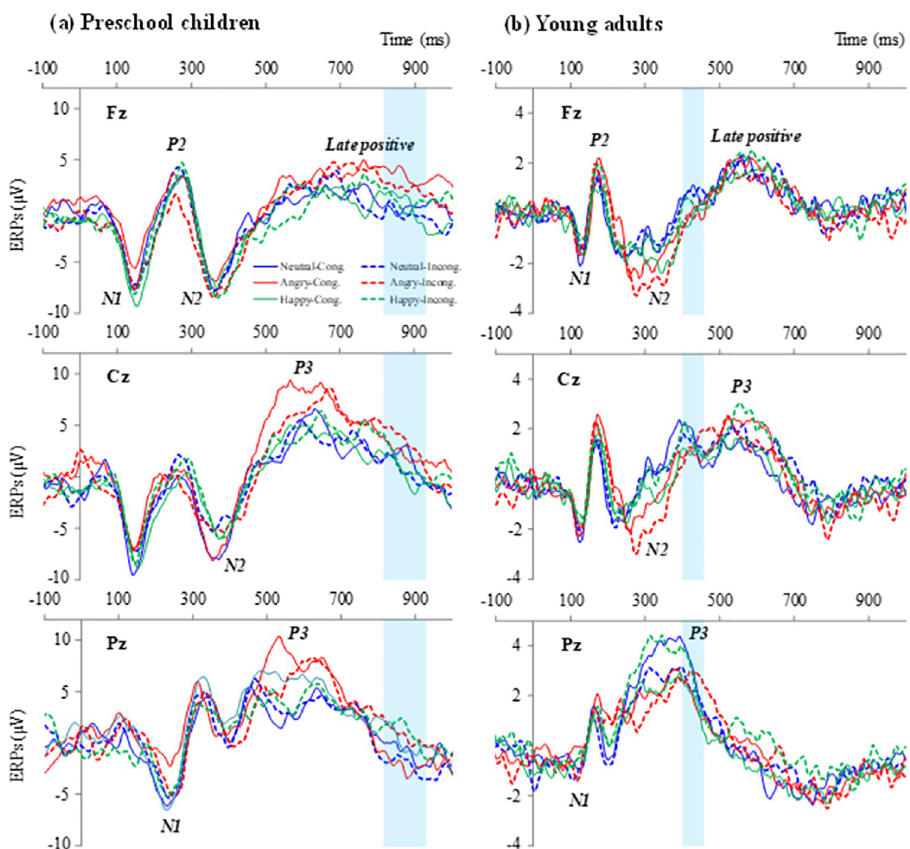
Fig 2. The grand averages of ERPs (N1, P2, N2, and P3) under all conditions at Fz ( upper ), Cz ( middle ), and Pz ( lower ) sites: (a) preschool children and (b) young adults. The blue background represents the range between the minimum and maximum values of mean reaction times for each group in the behavioral study, estimating the encoding and decision times for the EEG study.